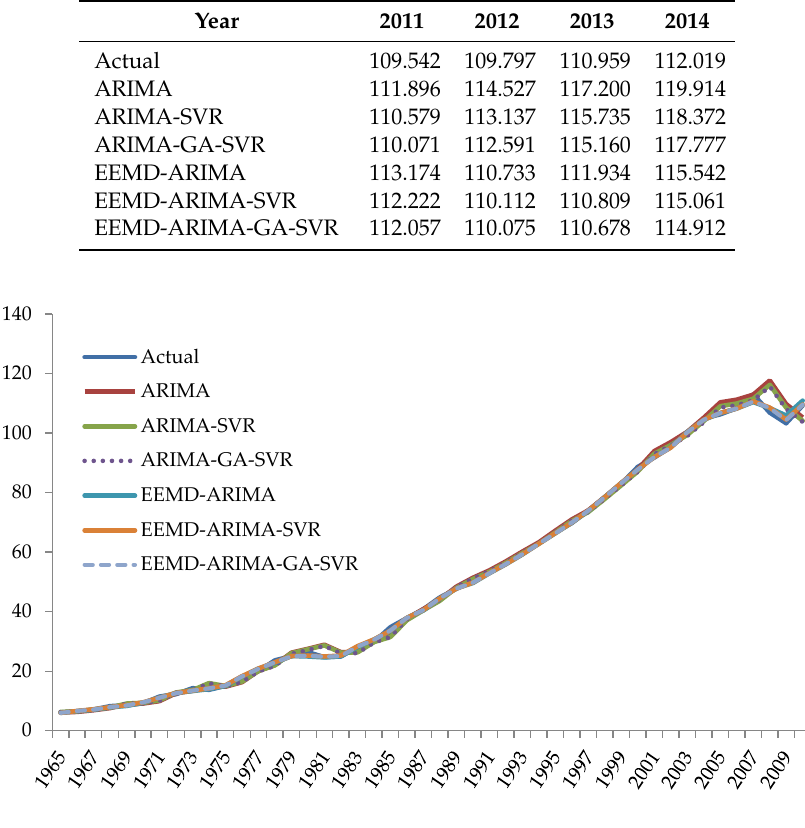
Figure 5. Fittings of the six models. Table 3. Data Test by four sample ranging from 2011 to 2014.